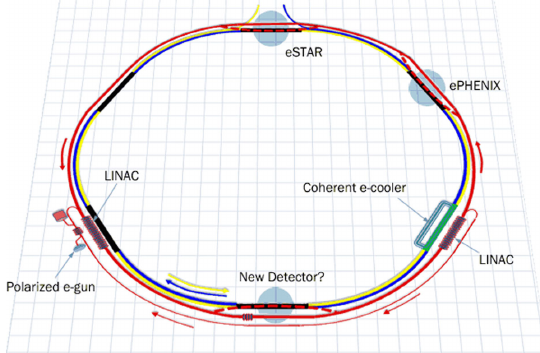
FIG. 1. Figure showing layout of the proposed electron ion collider at